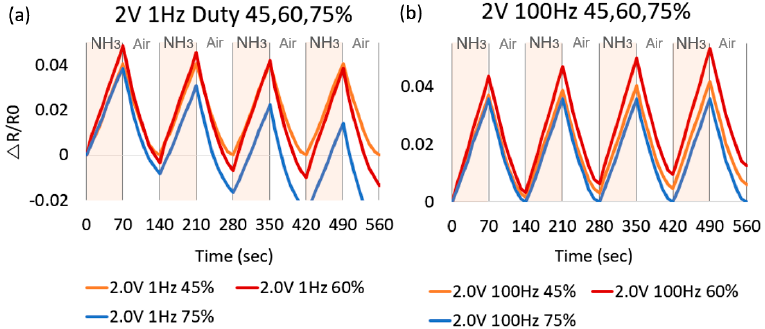
Figure 6. Comparison of sensing and recovery with varying duty cycles (0%, 60%, 100%). Adsorption cycle with NH 3(g) 18.8 sccm for 70 s and desorption cycle with air for 70 s are repeated for four cycles each. Ultra-low 1.05-mW energy consumption by optimized heating mode (2.0 V, 1 Hz, 60% duty cycle, red color) shows significant adsorption rate 0.049 (Δ R / R 0 ) per 70 s of sensitivity and desorption rate 0.052 (Δ R / R 0 ) per 70s of recovery.